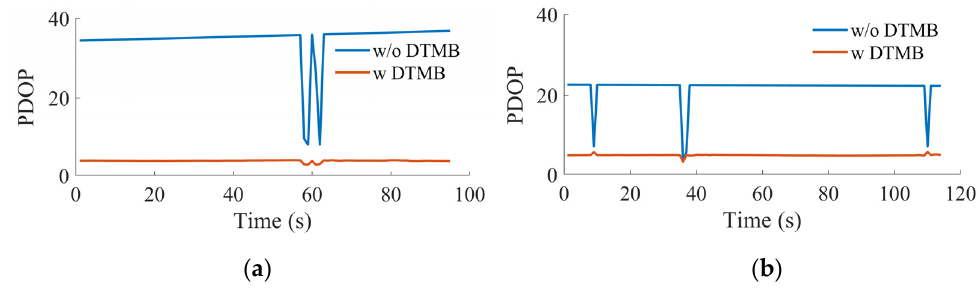
Figure 19. PDOP results in dynamic scenario when 4 satellites are visible. ( a ) Clockwise. ( b ) Coun- Figure 19. PDOPresultsindynamicscenariowhen4satellitesarevisible. ( a )Clockwise. ( b ter-clockwise.